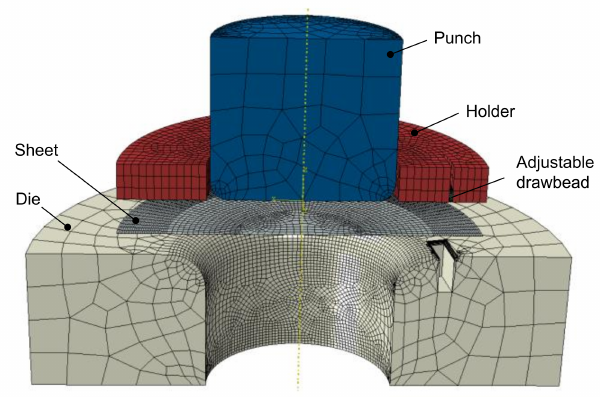
Figure 2. Finite element model of the cup drawing process.